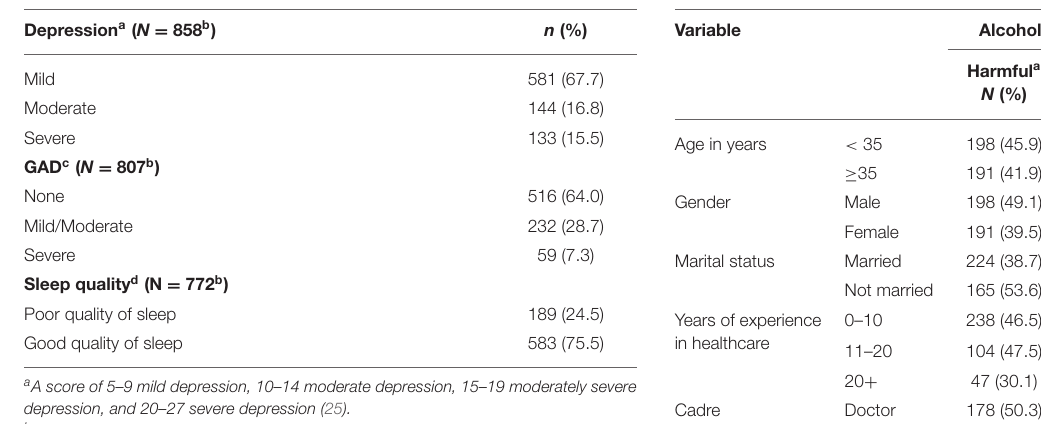
TABLE 3 | Bivariate analysis of socio demographic factors and harmful alcohol use.